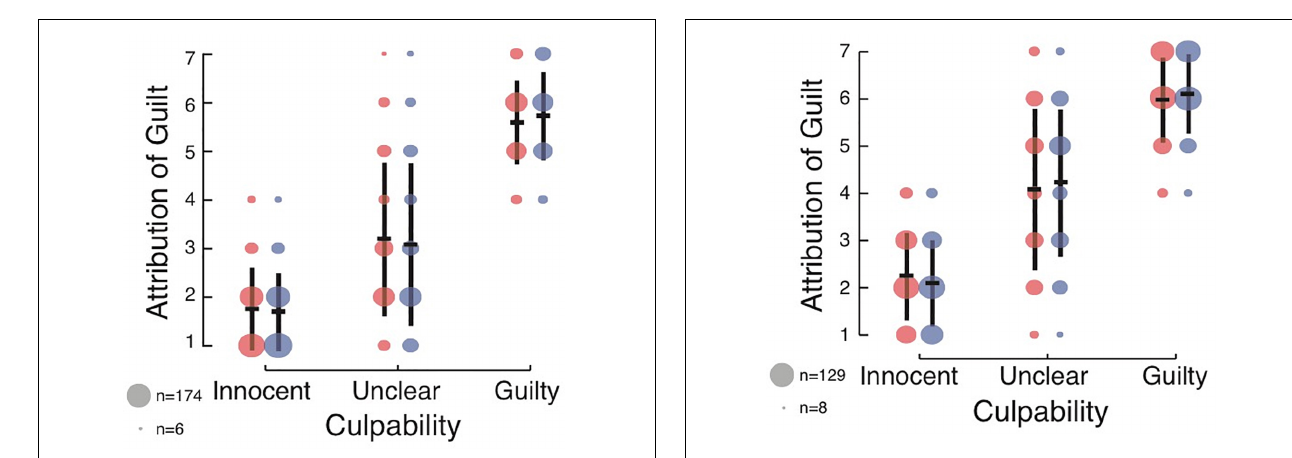
FIGURE 2 | Effect of culpability and DSF language on attribution of guilt for intent to kill in Experiment 2. The annotations are the same as those used in Figure 1 .